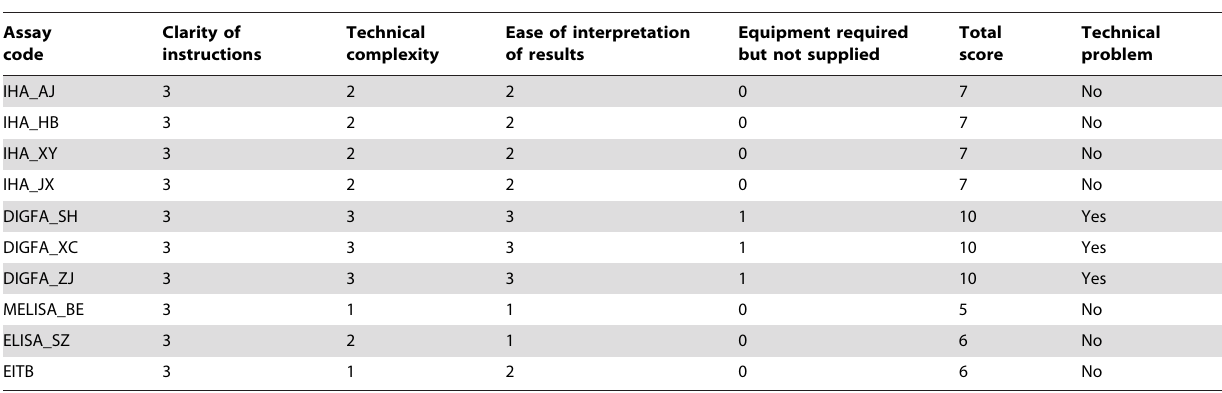
Table 5. Operational characteristics of the evaluated